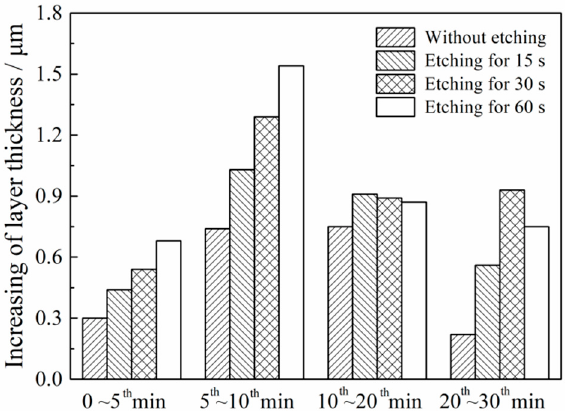
Figure 5. The thickness increasing of layers on different Al-12 Si during different MAO periods.